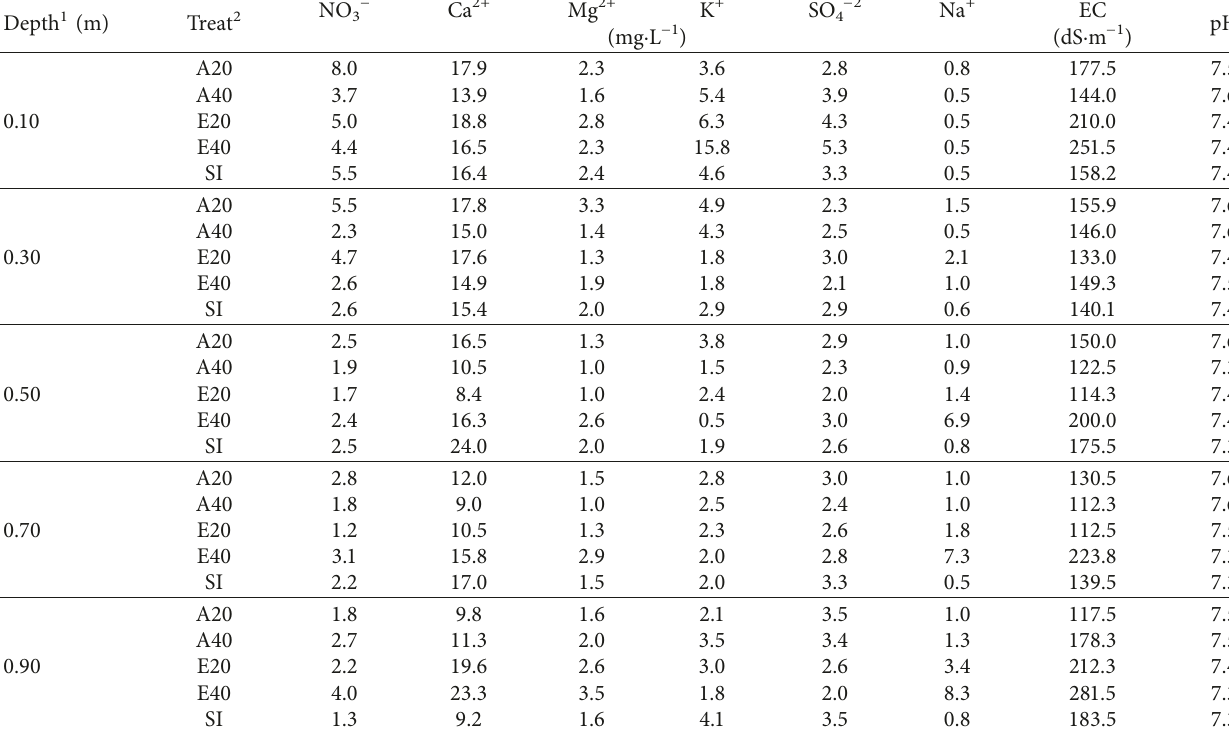
Table 4: Average anion and cation concentrations and values of electrical conductivity and pH in soil solution by the time of the first sugarcane